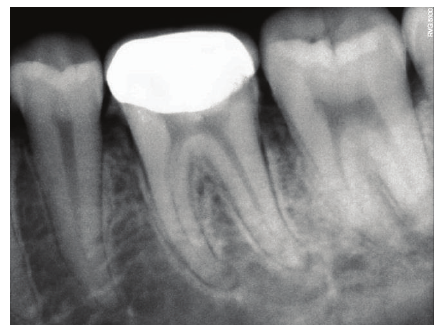
Figure 10: 12-month followup RVG 46.